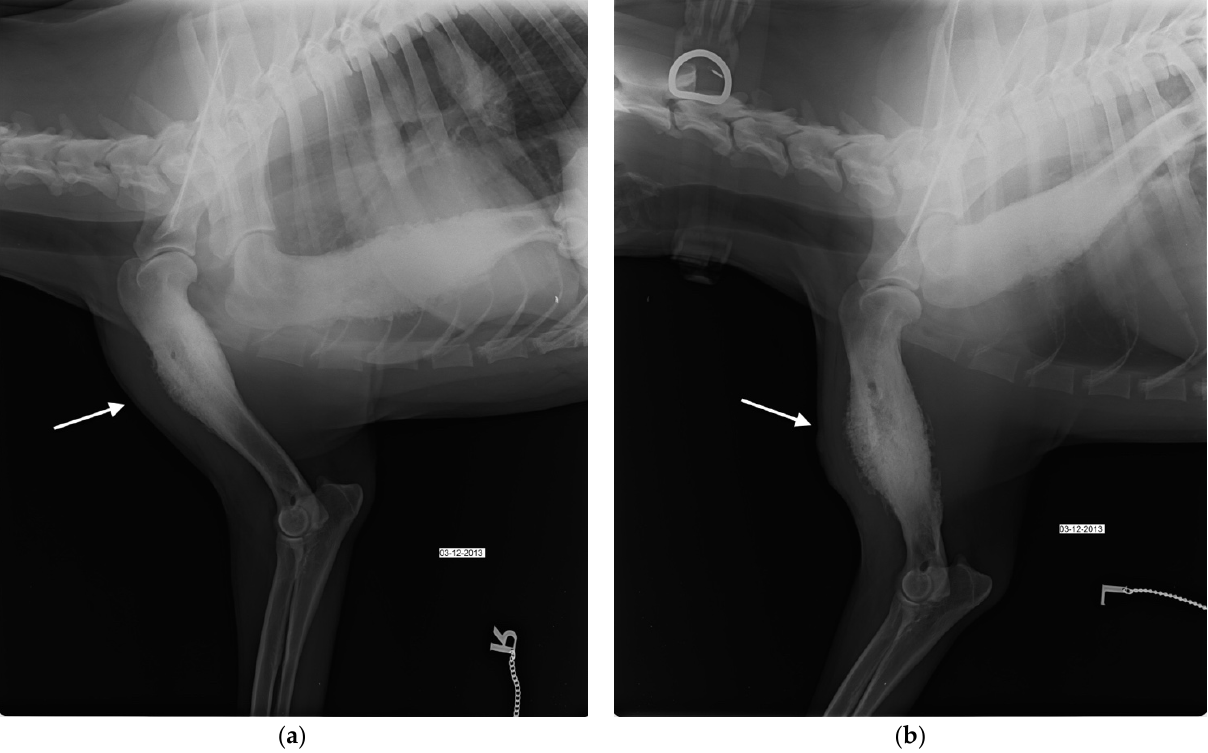
Figure 1. Mediolateral (ML) view of the left ( a ) and right ( b ) humerus at the day of first admission shows diffuse sclerosis and diaphyseal periosteal reaction (white arrow).